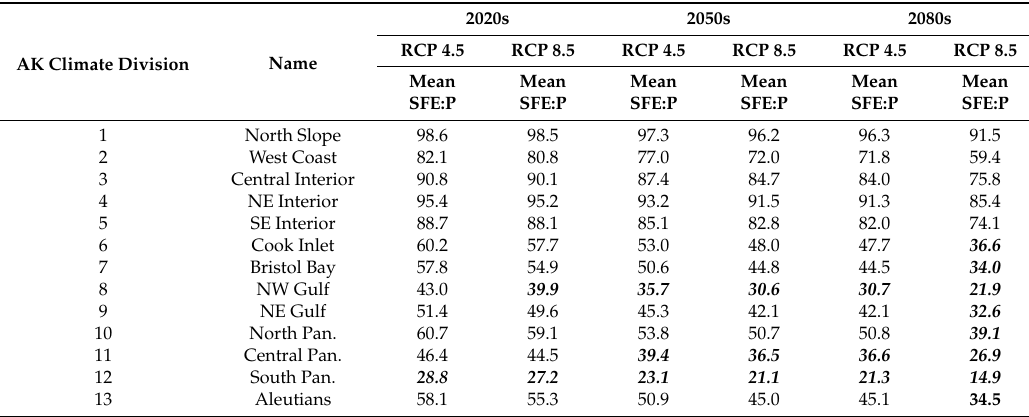
Figure 5. 2020s, 2050s, and 2080s five-model mean projected October–March SFE:P ratio for RCP 4.5 ( left ) and RCP 8.5 ( right ). Table 6. Mean SFE:P by Alaska Climate Division and climate scenario. All values are mean divisional change in SFE taken across the five GCM composite. Mean values of SFE:P representing transitional snow hydrology (no longer snow dominated) are in bold